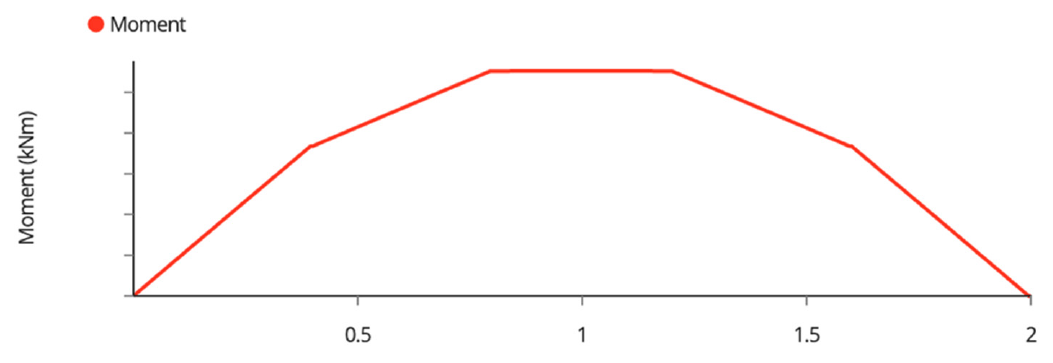
Figure A2. Joist Shear Force Diagram.